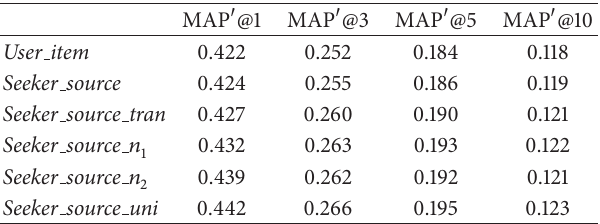
Table 2: Accuracy comparisons of different